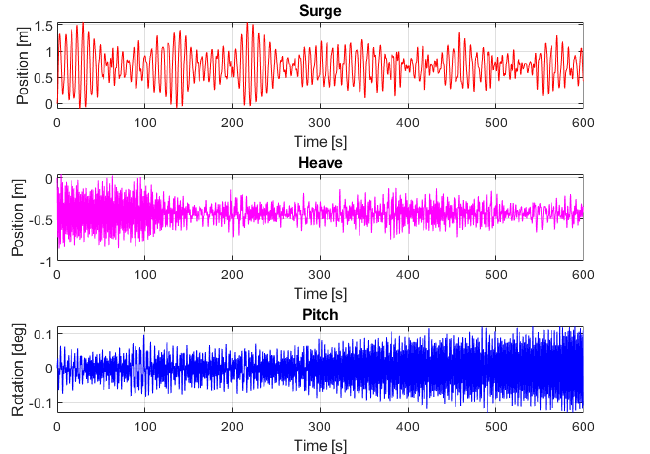
Figure 14. Surge, heave and pitch for Hs = 0.625 m, Te = 4.625 s and V = 8 m/s.